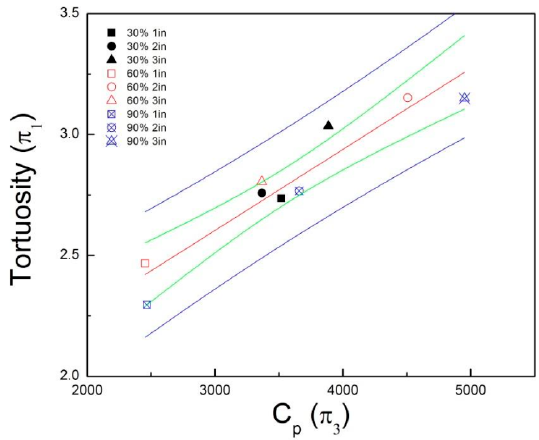
Figure 12. Confidence intervals for the correlation between π 1 and π 3 . Figure 12 . Confidence intervals for the correlation between 𝜋 (cid:2869) and 𝜋 (cid:2871) .